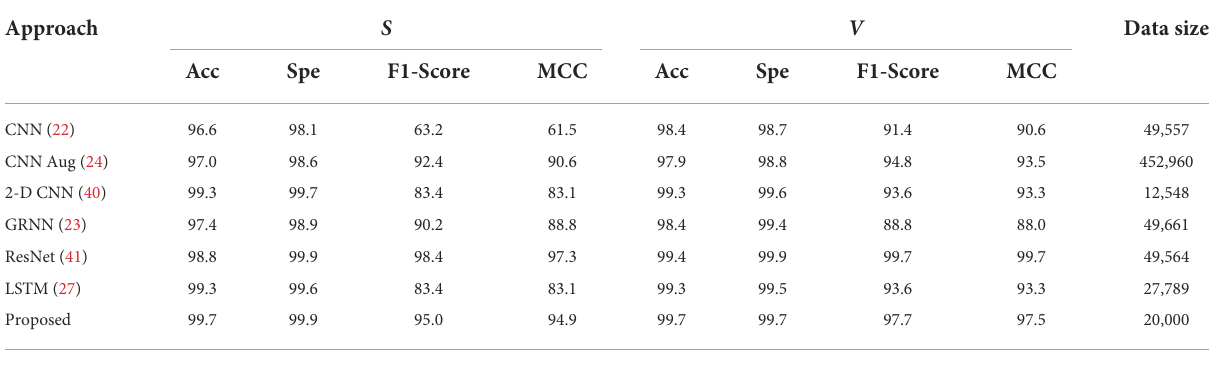
TABLE 2 Classification comparison of classes S and V.